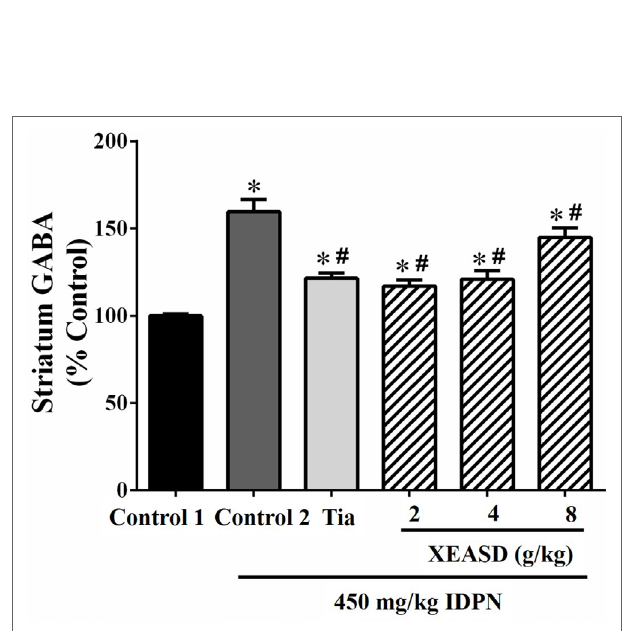
FIGURE 4 | Effects of XEASD treatment on gamma-aminobutyric acid (GABA) levels in brain striatum of IDPN-induced TS mice. Biochemical assay of striatal GABA levels was performed as described in Materials and Methods. Control 1 represents normal control mice; control 2 represents IDPN-challenged control mice. Data are expressed as the percentage of non-challenged control 1 values. * P < 0.05, significantly different from the control 1; # P < 0.05, significantly different from the IDPN control 2. The value of GABA level of control 1 (mean ± S.E.M.) = 2.03 ± 0.15 (pg/mg